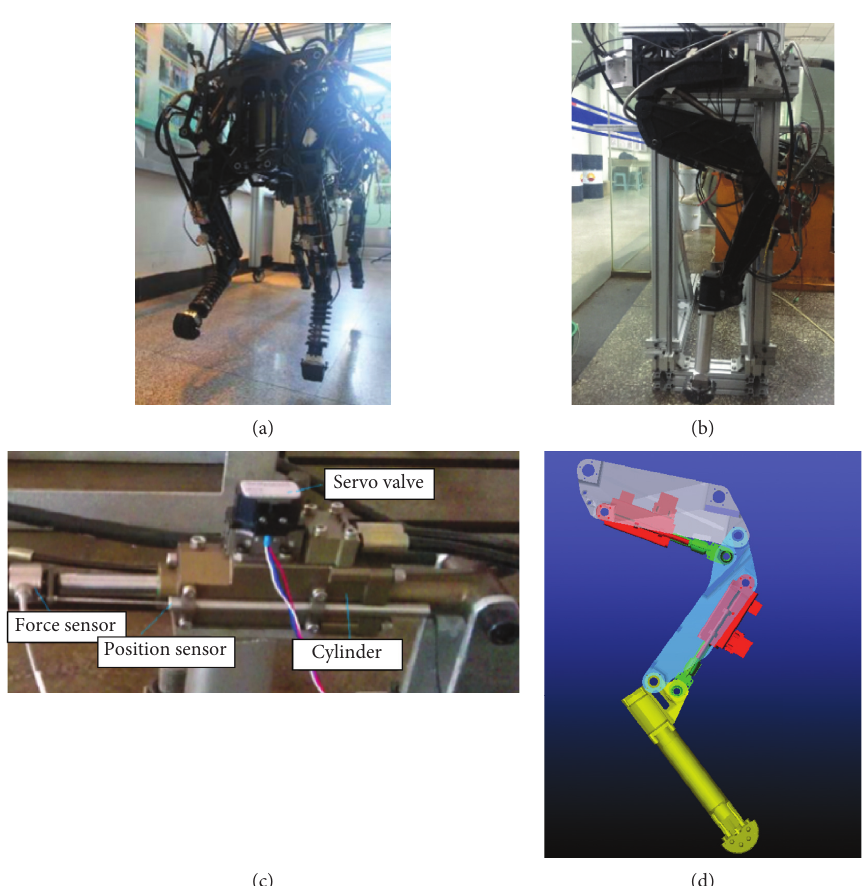
Figure 1: Photo of the (a) legged robot prototype, (b) single leg hydraulic drive system, (c) HDU, and (d) 3D model of the single